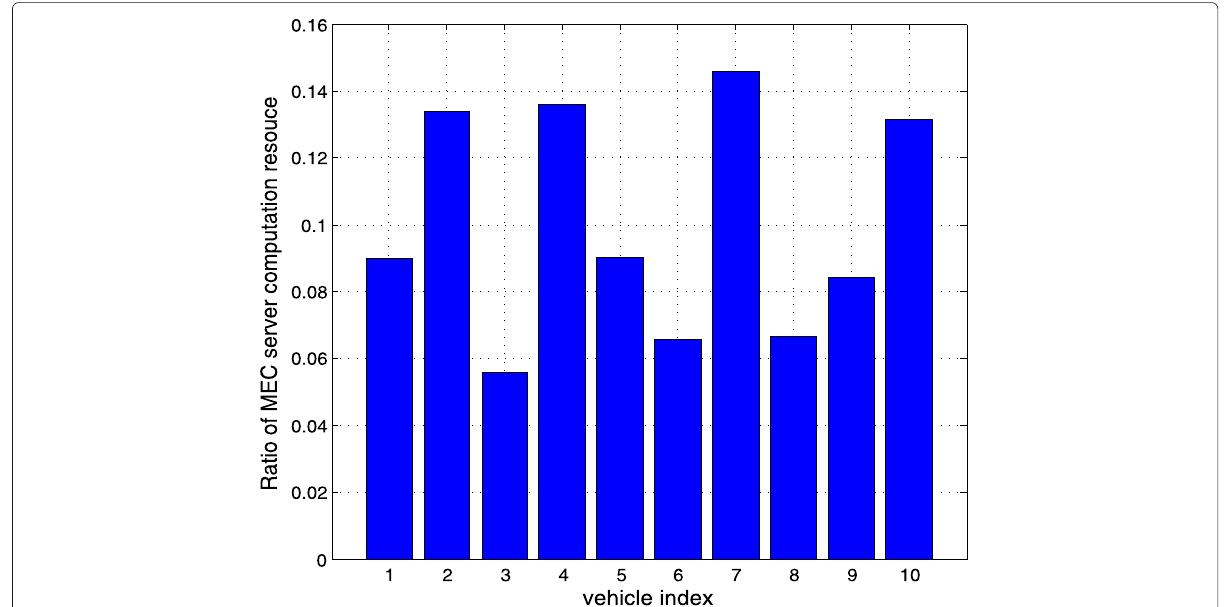
Fig. 9 The ratio of the computation resource allocated to vehicles to the total computation resource of the MEC server